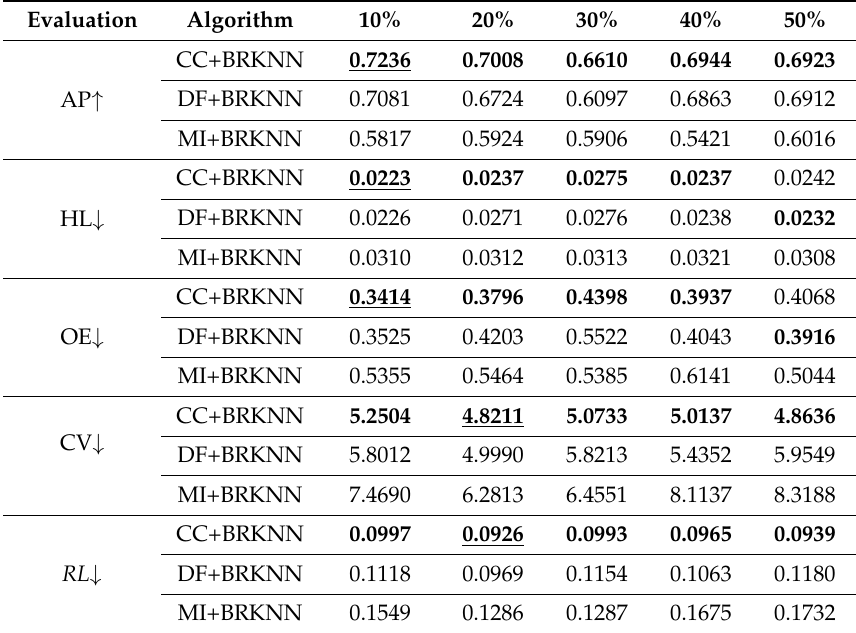
Table 14. Comparison of classification performance on Social data